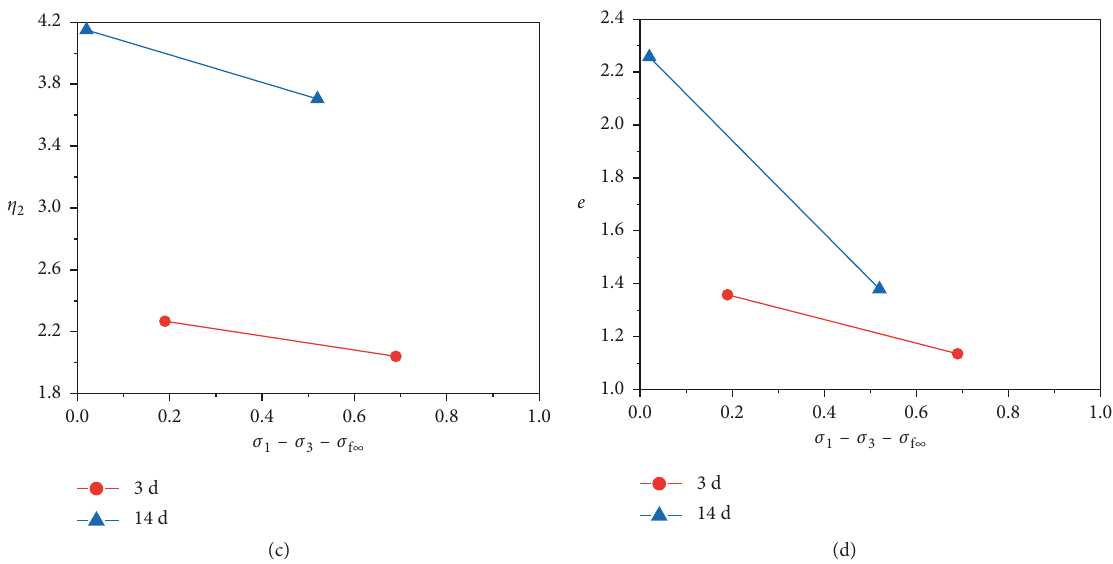
Figure 15: The variation in creep parameters ( σ